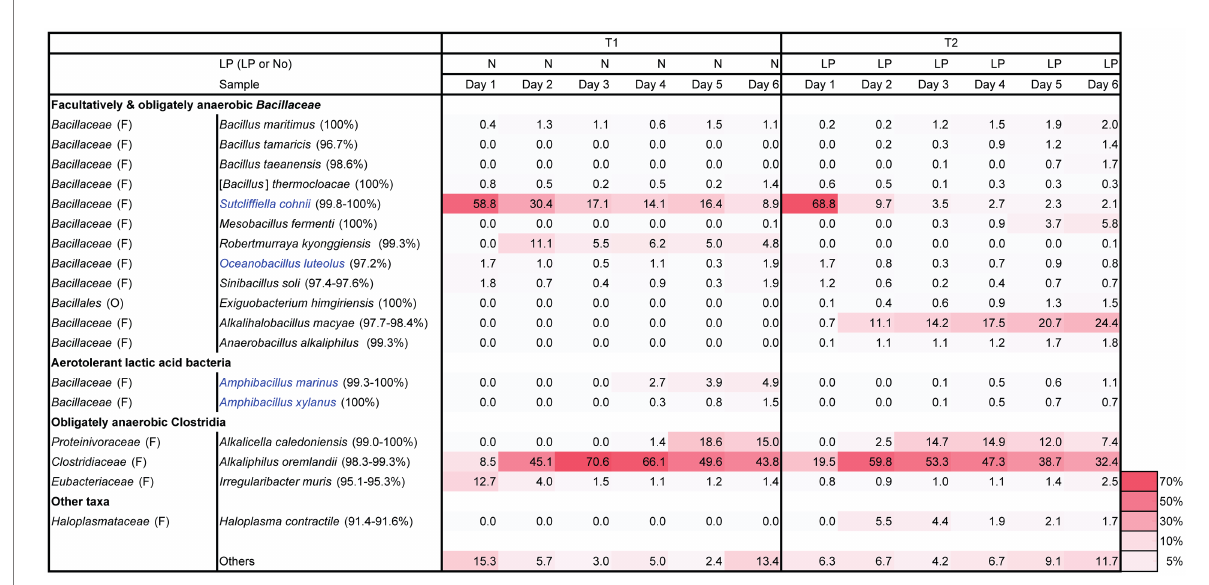
FIGURE 1 Changes in the relative abundance of bacterial communities ( ≥ 1.4% in any sample), based on 16S rRNA analysis. Blue letters indicate the confirmed indigo-reducing taxa (including unpublished results). The percentages in the brackets indicate the similarities with the known species in the NCBI